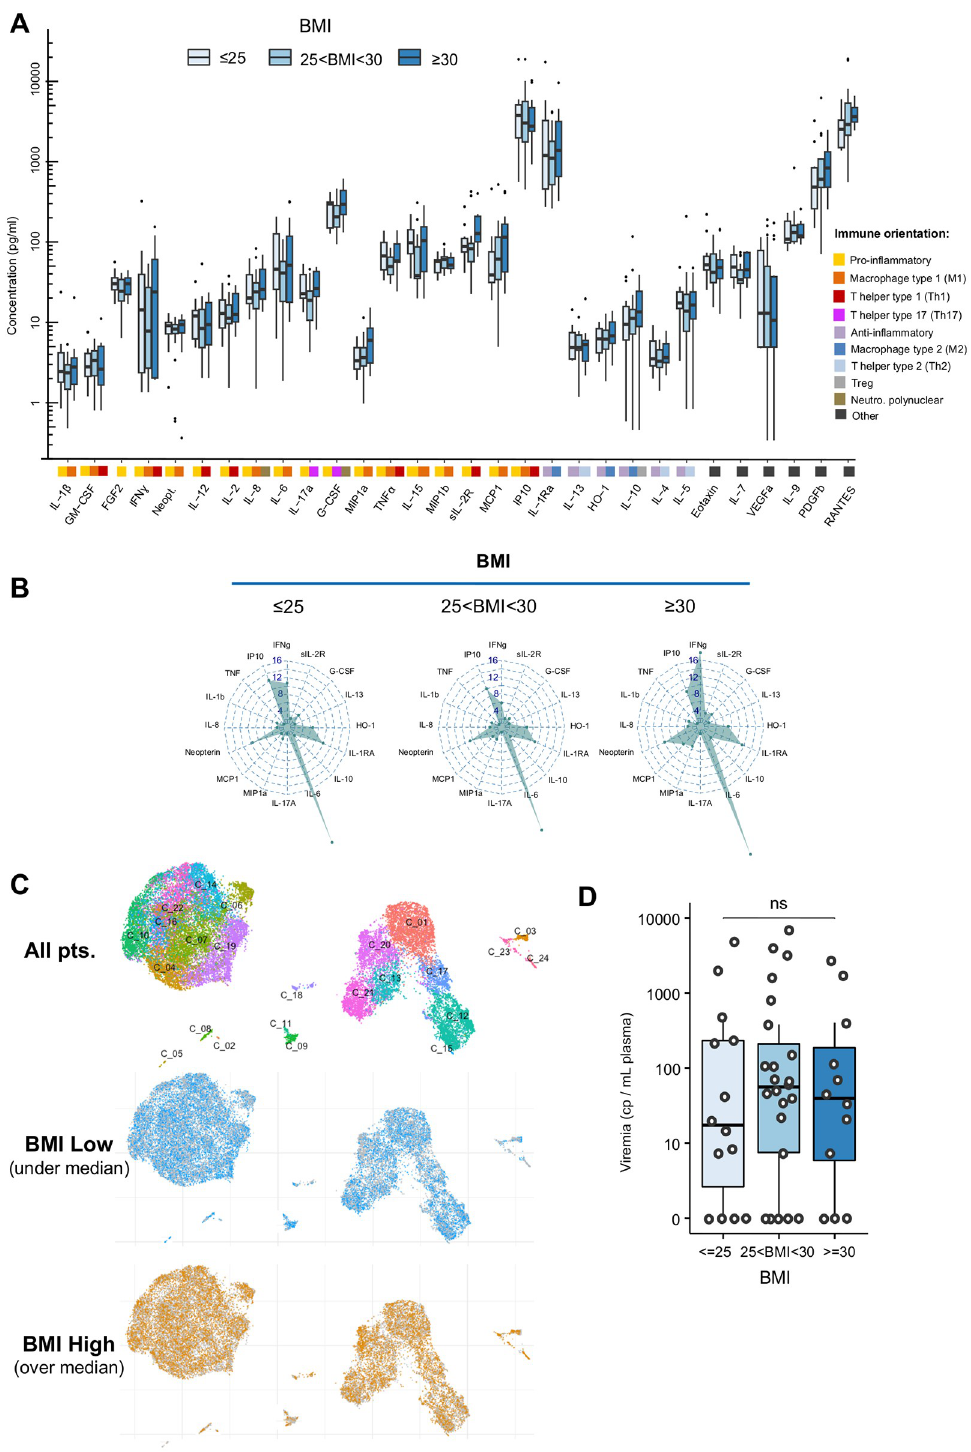
Fig 1. (A) Box plots illustrating the concentration of cytokines according to the BMI levels in COVID-19 patients with BMI � 25, 25 < BMI < 30, and BMI � 30. The colored squares associated with each cytokine illustrate the different orientations of the immune response (n = 42 patients). (B) Radar plots illustrating the fold increase of selected cytokines in patients with BMI � 25 (n = 11), 25 < BMI < 30 (n = 19), and BMI � 30 (n = 12), as compared to healthy donors (n = 18). (C) Characterization of peripheral blood mononuclear cells according to the BMI categories (above and below